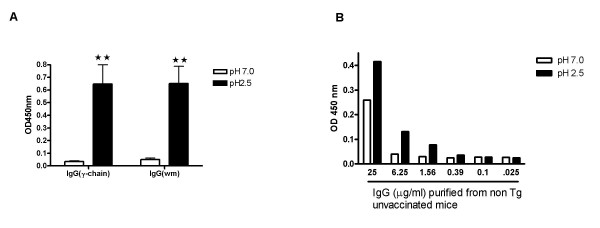
Incubation at pH 2.5 induced artifactual ELISA signal appears to be IgG associated. Panel 2A. Normal sera were collected from nonTg unvaccinated mice, diluted 1:400 and preincubated at either pH 7 (open bars) or pH 2.5 (solid bars) as described in methods. After centrifugation, neutralization and reconstitution of sera volume, the sera were incubated on the ELISA plates coated with human Aβ1–42 for 60 minutes. After washing the plate, anti-mouse gamma chain specific (left) or anti-mouse whole IgG (right) were pipetted into the different wells of plate. Panel 2B. Normal sera from nonTg unvaccinated mice were incubated at pH 7.0 (open bars) or pH 2.5 (solid bars) and then IgG was purified with protein A/G (Pierce) as described in methods. Protein was measured with BCA protein assay Kit (Pierce), and dilutions of the purified IgG were incubated as the indicated concentrations on ELISA plates coated with Aβ1–42. ELISA assays were completed as described in methods. ** P < 0.001 compared to pH 7.0.